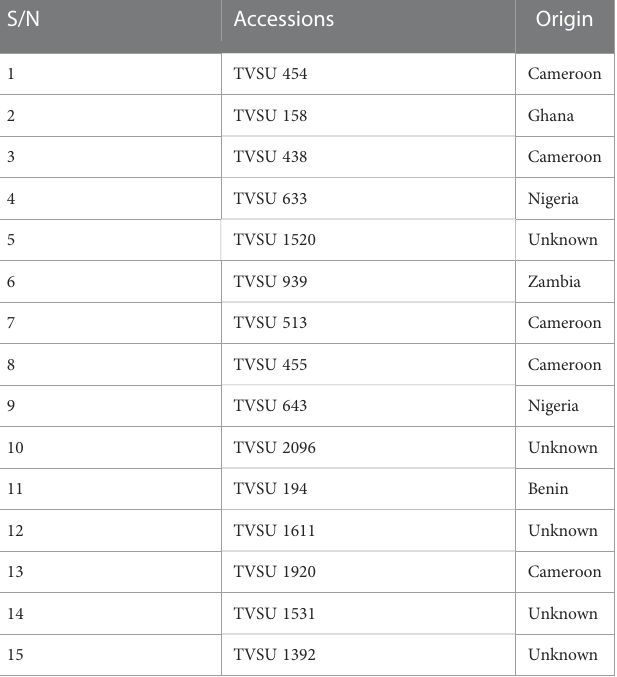
TABLE 2 The accessions of Bambara Groundnut and their collection